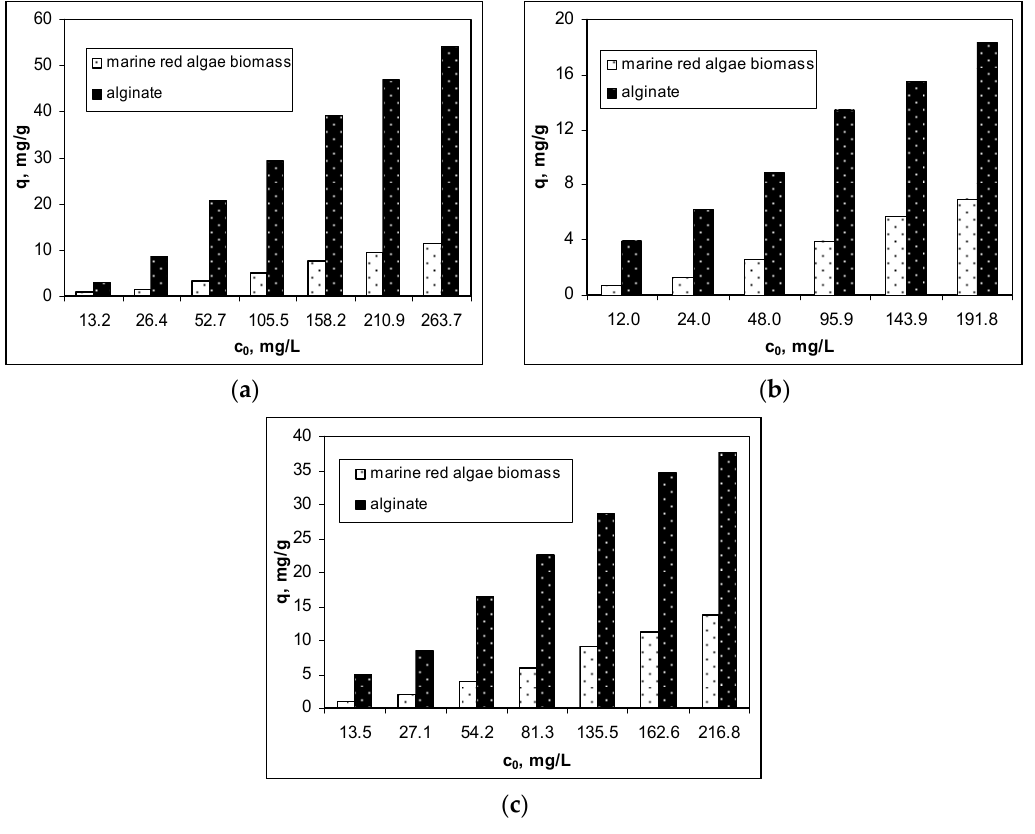
Figure 7. Comparison of the performances of marine red algae biomass and alginate for the biosorption of: ( a ) Cu(II), ( b ) Co(II) and ( c ) Zn(II) ions.